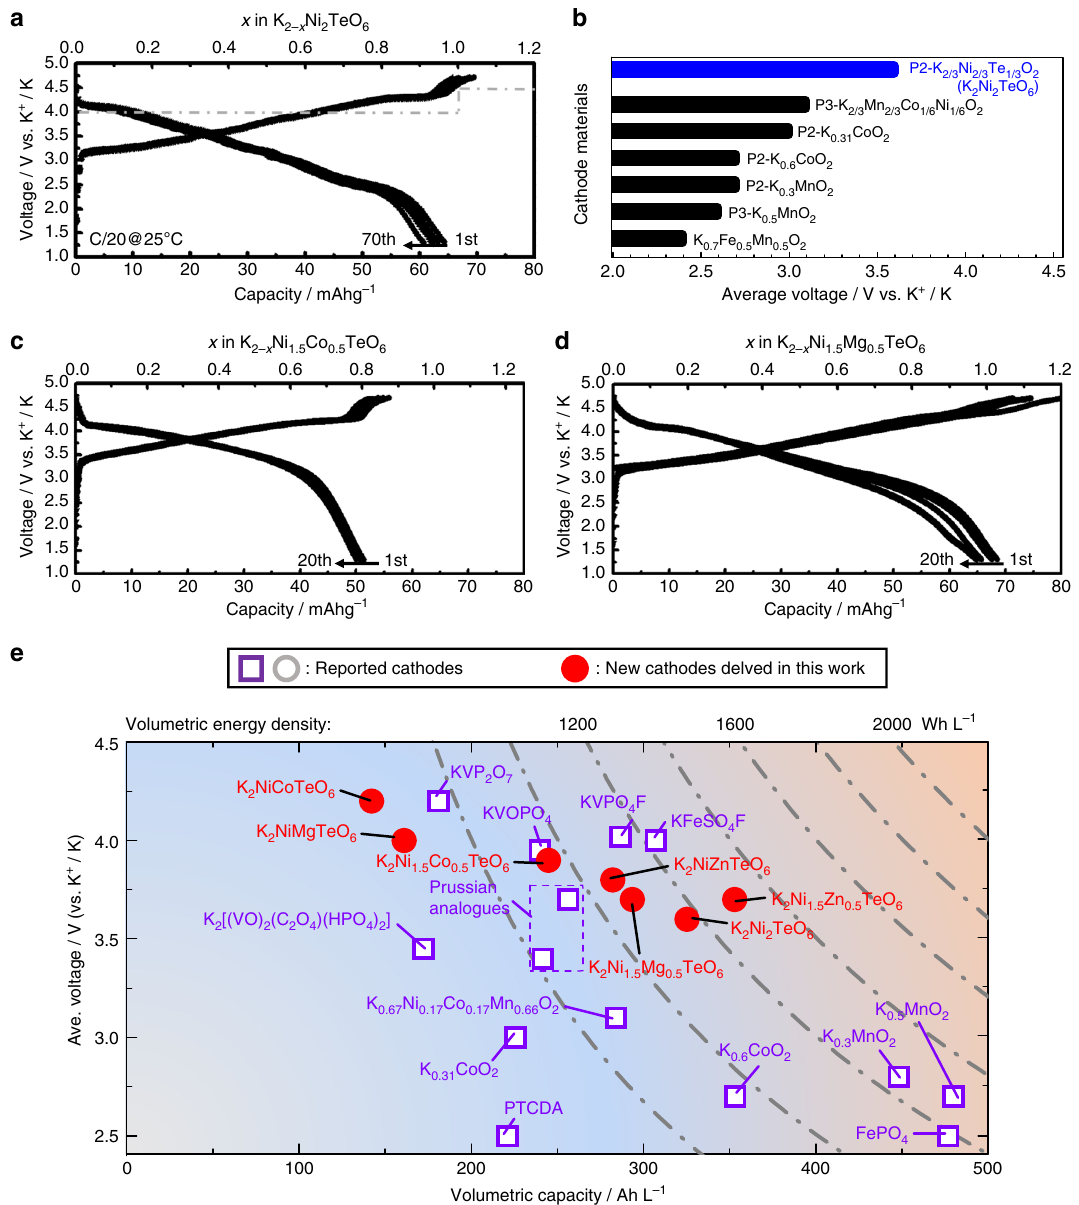
Fig. 3 Electrochemical performance of K 2 Ni 2 TeO 6 prototype cathode material along with its K 2 Ni 1 – x M x TeO 6 ( M = Mg, Co, Zn) solid solution derivatives. a Voltage-capacity pro fi les (70 cycles) for K 2 Ni 2 TeO 6 in K half-cells using ionic liquid (0.5 M KTFSI in Pyr 13 TFSI). Galvanostatic measurements were conducted at C/20 rate at room temperature. The grey dashed line indicates the calculated voltages. The 1st, 5th, 10th, 20th and 70th voltage pro fi les have been shown for brevity ’ s sake. b Performance of new tellurate compounds benchmarked with reported layered cathode frameworks for potassium-ion battery (KIB), underlining the tellurate cathodes as high-voltage contenders. Voltage-composition plots of c Co-substituted K 2 Ni 1.5 Co 0.5 TeO 6 and d Mg- substituted K 2 Ni 1.5 Mg 0.5 TeO 6 derivatives. For the sake of readability, the 1st, 5th, 10th and 20th voltage pro fi les have been shown. e The average (dis) charge voltage (V versus K + /K) against volumetric capacity (Ah L – 1 ) and volumetric energy density (expressed as Wh L – 1 ) for selected cathode materials for KIB. The volumetric energy densities of the cathode materials were calculated based on material density. Further details pertaining to the calculations